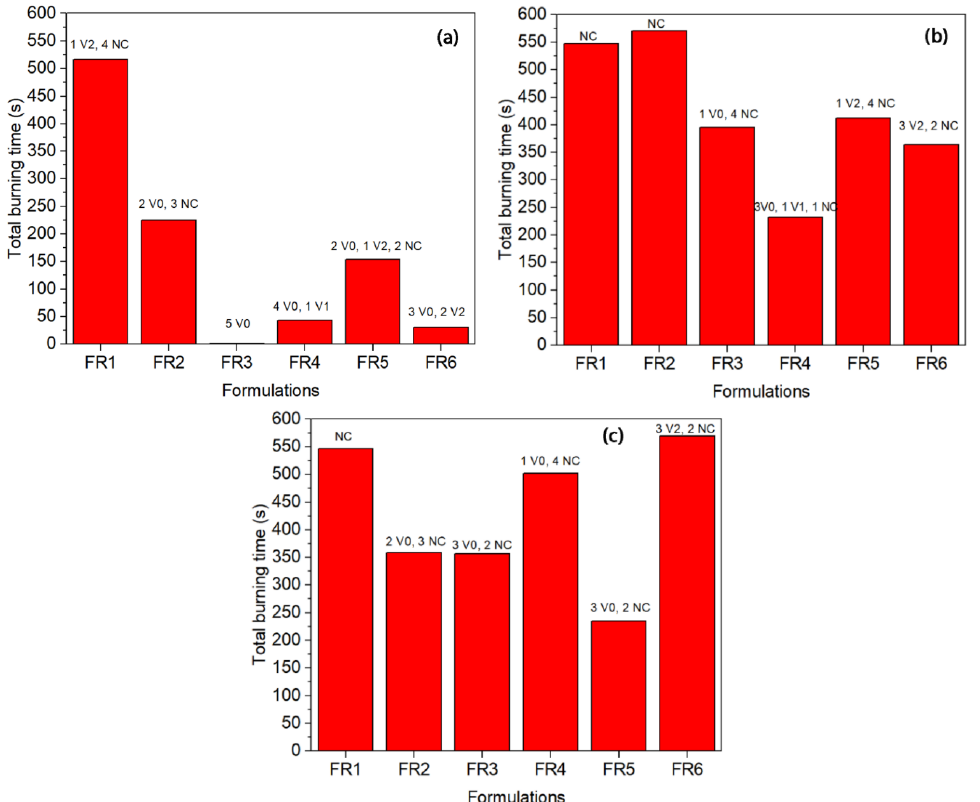
Figure 4. UL 94 V results (total burning time, ranking) for FR-containing polyethylene grades. ( a ) LDPE-A, ( b ) LDPE-T, ( c ) LLDPE. ( a ) LDPE-A, ( b ) LDPE-T, ( c )